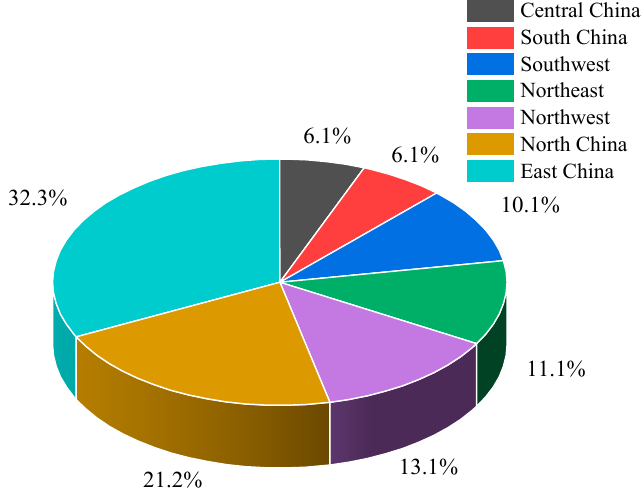
Figure 1. Regional layout of China’s coal energy industry.